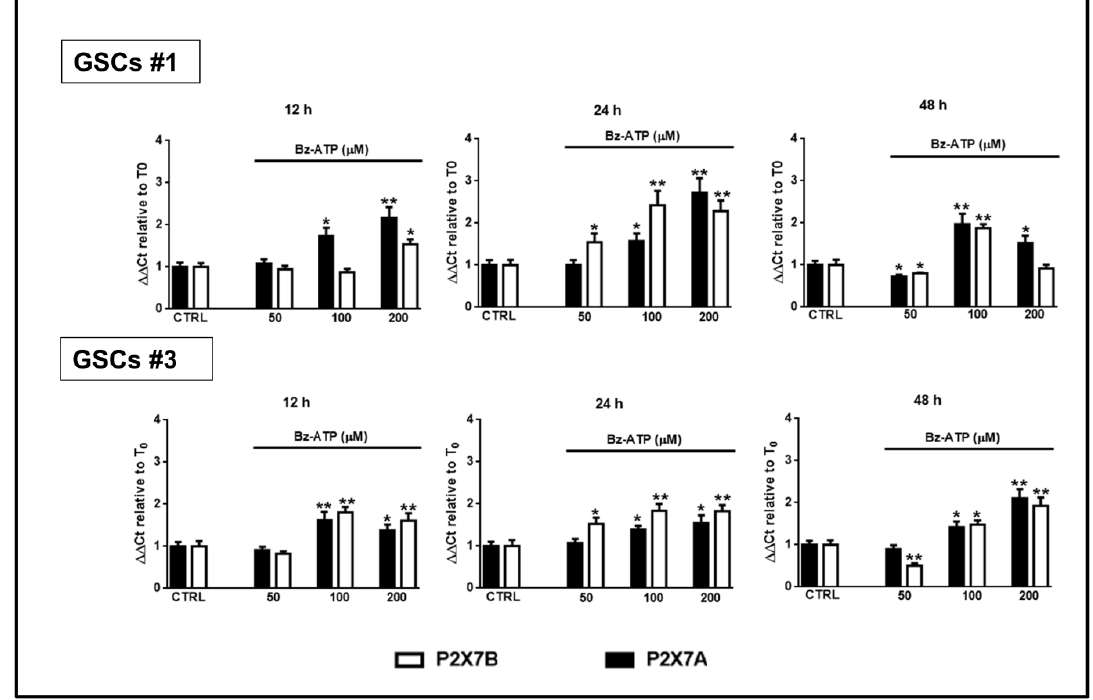
Figure 12. Modulation of the expression of the P2X7R splice variants A and B in GSCs exposed to BzATP. GSCs #1 and #3 were exposed to BzATP. At the indicated time points cells were collected to